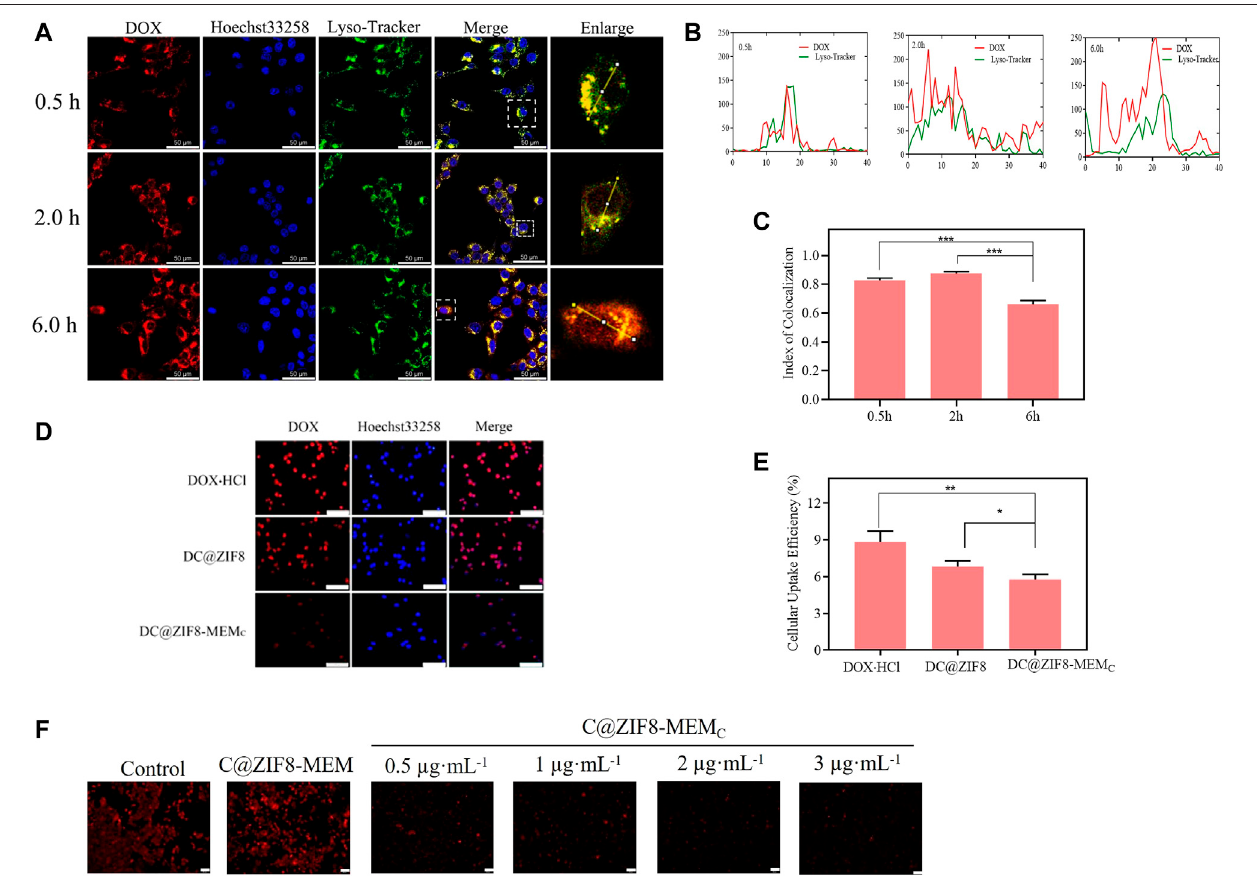
FIGURE5| Intracellular distribution fl uorescenceimagingofDC@ZIF8-MEM C atdifferenttimesbyconfocallasermicroscopy(CLMS);scalebar = 50 μ m (A) .Line- scan pro fi les of DC@ZIF8-MEM C and Lysotracker after 0.5, 2, and 6 h incubation by ImageJ software. The level of the overlapped green line and red line is negatively correlated to endosomal escape of DC@ZIF8-MEM C (B) . The index of colocalization of endocytosed DC@ZIF8-MEM C (red) and endosome (green) was calculated by ImageJ software (C) . Cellular uptake of different samples incubated with RAW 264.7 cells for 24 h by fl uorescent microscope; scale bar = 100 µm (D) . Cellular uptake ef fi ciency of different samples to RAW 264.7cells by microplate reader (E) . Fluorescence images of 4T1 cells incubated with different samples and then stained with Ru